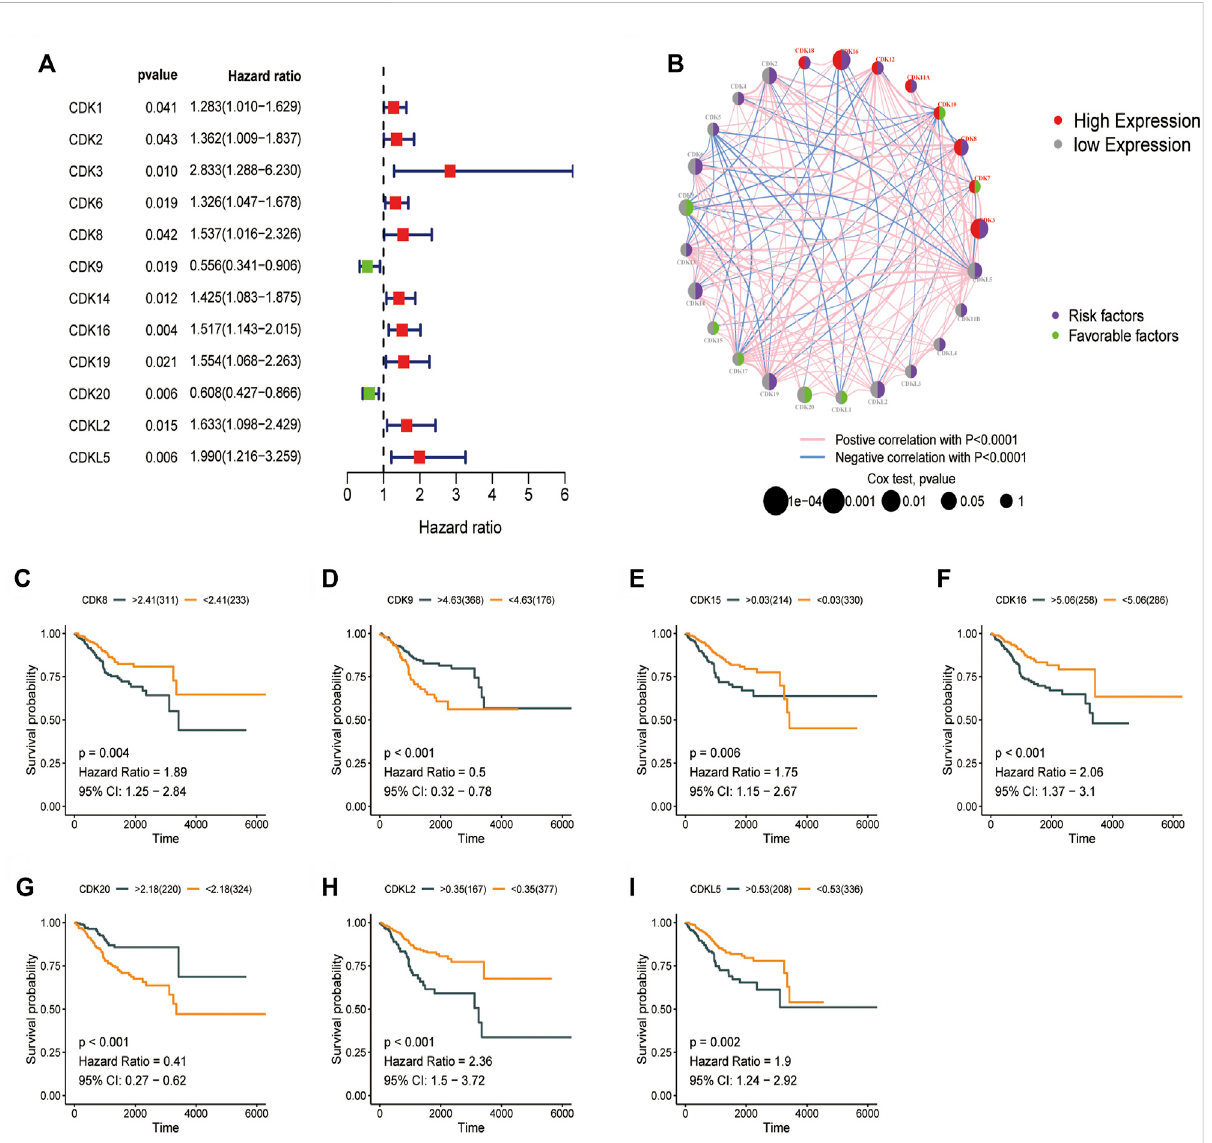
FIGURE 3 Prognostic signi fi cance of CDK family genes. (A) Univariate Cox regression analysis was used to analyze CDK family genes. (B) Circos plot for univariate cox regression analysis showing the relationship between the prognosis of EC and high ( > 5, red) and low ( < 5, grey) expression of CDK genes in TCGA-UCEC dataset (purple, risk factors; green, favorable factors). The p -values in Cox regression analysis ranged from 1e-04 to 1 (the larger the bubble, the higher the correlation). (C – I) Survival curve of the impact of CDK8, CDK9, CDK15, CDK20, CDKL2, and CDKL5 on OS in TCGA-UCEC